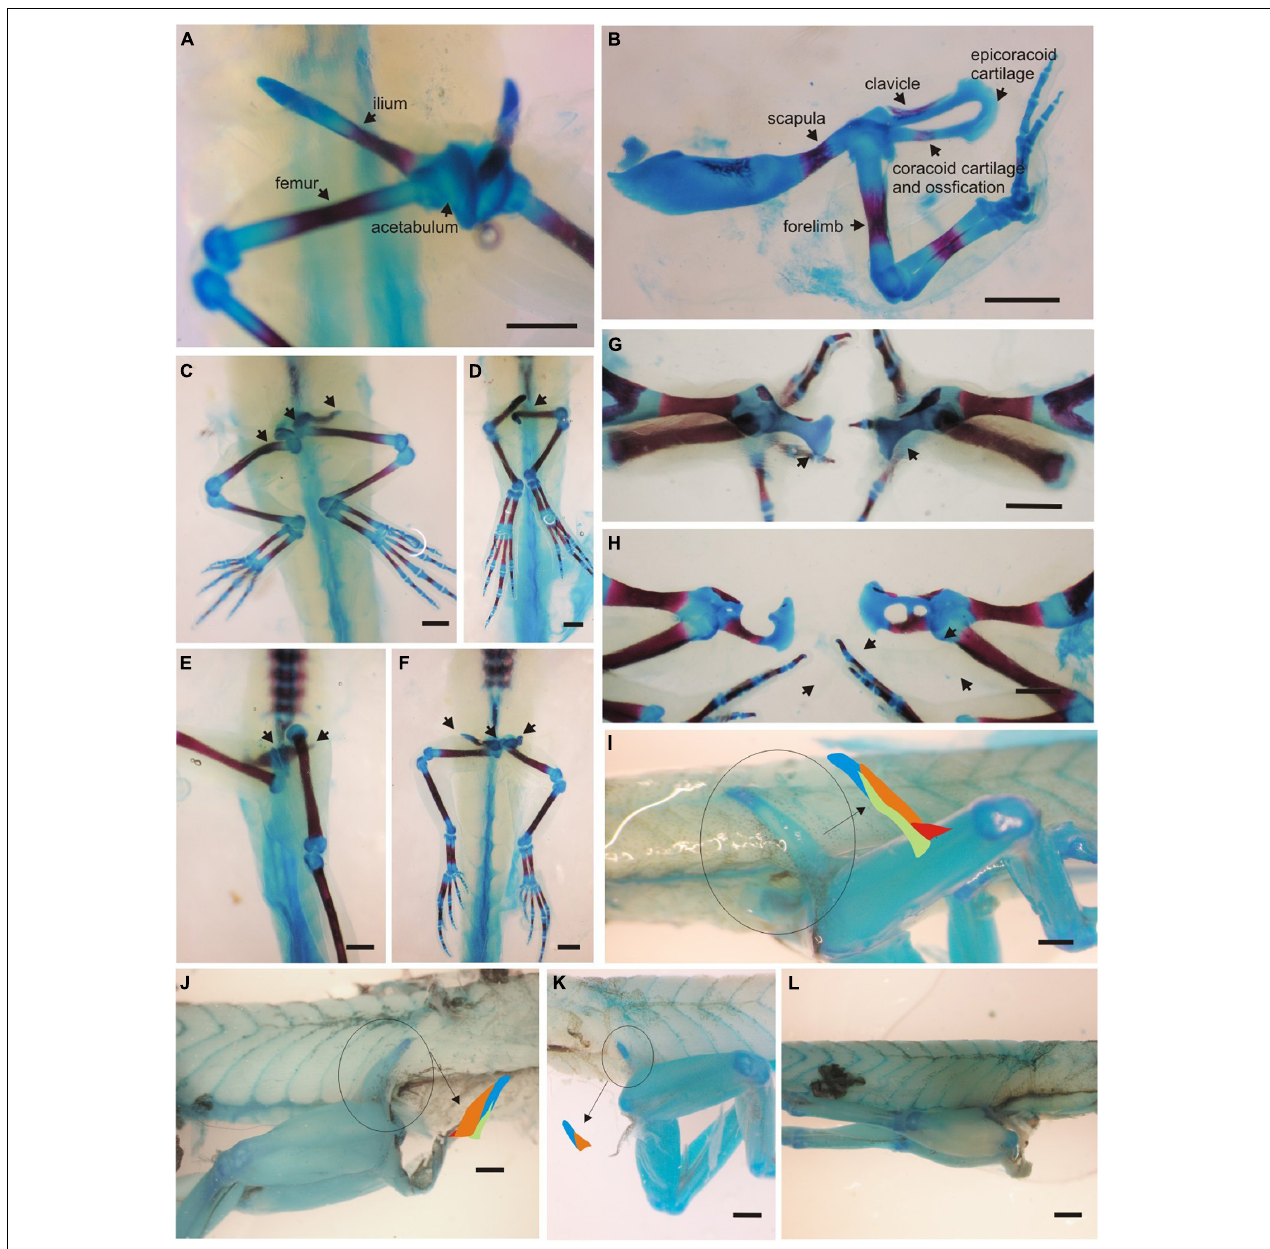
FIGURE 8 | Abnormalities in girdles and limb skeletons and muscles. (A) Ventral view of the pelvis in a control specimen (Gosner Stage 40). (B) Right pectoral girdle and forelimb in a control specimen (Gosner Stage 40). (C,D,G) Girdle and limb skeleton in specimens exposed to methimazole at the end of experiments. (C) Femurs hung from rudiments of pelvis, right femur is curved, and the ilion is short. (D) Underdevelopment of pelvis and hind limbs joined by soft tissues to hypaxial muscles. (G) The coracoid cartilage is present but the procoracoid and the ossification of clavicle are defective. (E,F,H) Girdle and limb skeleton in specimens exposed to T4 at the end of experiments. (E,F) In both specimens the acetabulum is not well formed and the ilium is short. (H) The cartilaginous elements of each half of the girdle (coracoid, procoracoid and epicoracoid) show unequal differentiation and growth. (I) Lateral view of pelvis muscles (pelvis to femur) in control specimen at the end of experiment (Gosner Stage 38). The iliac shaft reached the limit between hypaxial and epaxial musculature. The schematic representation described the organization of three pelvic muscles: the muscle iliacus internus (red) originated at the basis of the ilium (blue) and inserted on the femur; the muscle iliacus externus (orange) attached along the anterior half of the iliac shaft and the tensor fasciae latae (green) from the laterointernal surface of the ilium to the thigh. This pattern is observed in the adult of Pleurodema borellii (Fabrezi et al., 2014). (J) Specimen under early exposure to methimazole after 31 days of larval development (Gosner Stage 38). The iliac shaft reaches the inferior half of hypaxial musculature and the muscles are also short. The tensor fasciae latae have loose fibers. (K,L) Specimens (Gosner Stage 38) under early exposure to T4 at the end of experiments. (K) The underdevelopment of the short iliac shaft is complemented with a short muscle iliacus externus. (L) The specimen without pelvic girdle and absence of pelvic muscles. The thigh is attached by soft connective fibers to hypaxial muscles as is observed in detail in (K). Bar is equal to 1 mm.